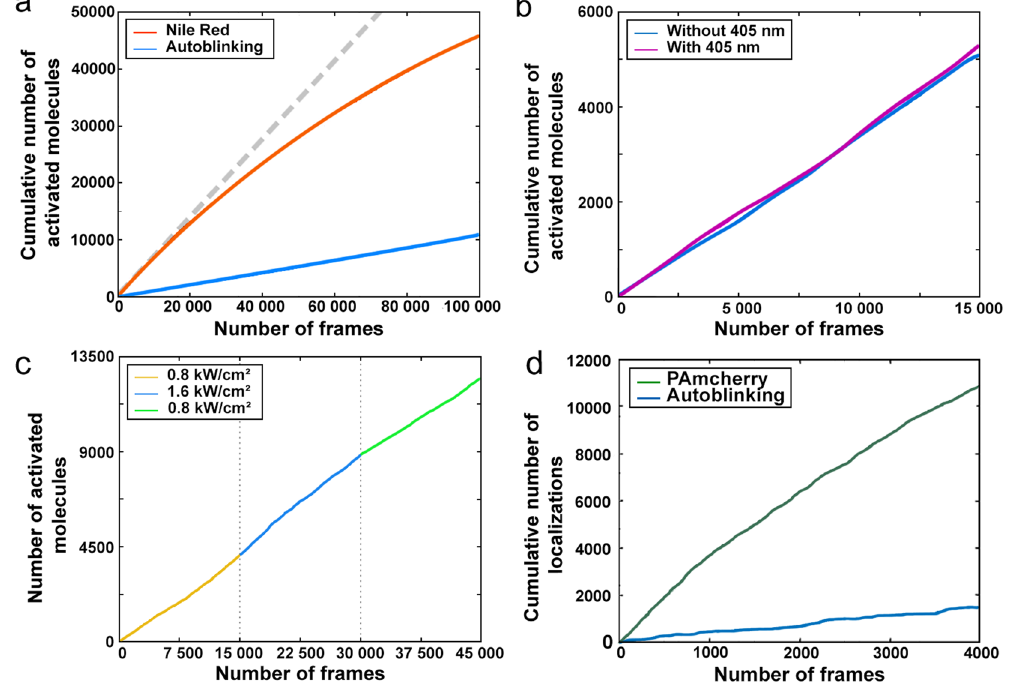
Figure 6. Photophysical properties of autoblinking molecules. ( a ) Cumulative number of autoblinking molecules (blue) under constant 561 nm laser illumination (0.8 kW/cm 2 ), compared to Nile Red (orange). Accumulation of autoblinking molecules follows a linear regression, while that of Nile Red progressively slows down during the data acquisition. ( b ) Cumulative number of activated autoblinking molecules under constant 561 nm laser illumination (0.8 kW/cm 2 ) in the presence (violet) and absence (blue) of constant 405 nm illumination. ( c ) Cumulative number of activated autoblinking molecules under varying 561 nm laser illumination (0.8 kW/cm 2 , yellow; 1.6 kW/cm 2 , blue; 0.8 kW/cm 2 , green). Accumulation of autoblinking molecules follows a linear progression and is only marginally affected by the increased laser power. (a-c) Images were acquired with a 50 ms timeframe. ( d ) Cumulative number of localizations of cytoplasmic PAmCherry (green) expressed in D. radiodurans and of autoblinking molecules (blue). PAmCherry localizations were acquired first using a 5 ms timeframe, constant 561 nm illumination (0.8 kW/cm 2 ) and varying 405 nm laser,